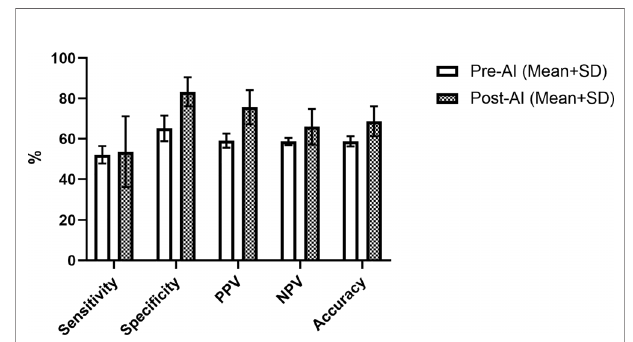
FIGURE 4 | Radiologist performance using TI-RADS criteria alone (white) and TI-RADS with AI assistance (checkered) for predicting the risk of thyroid nodules on